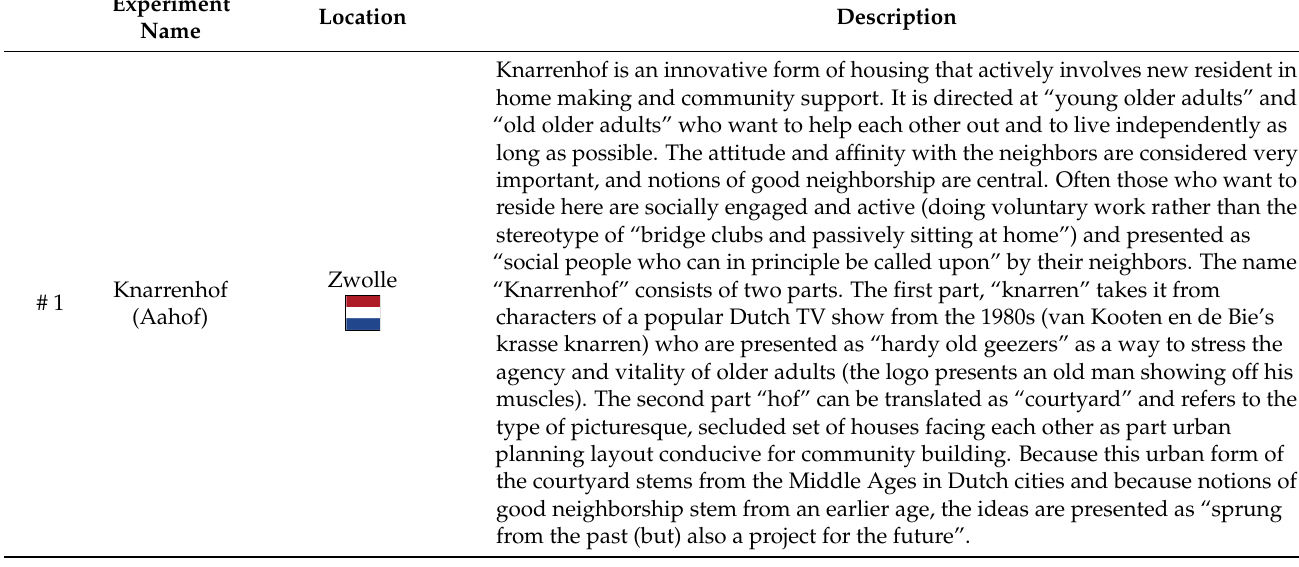
Table 2. Overview of 8 key age-friendly home experiments in the Netherlands, France, Ireland and Poland (see Table A1 in Appendix A for the complete overview of 53 experiments).